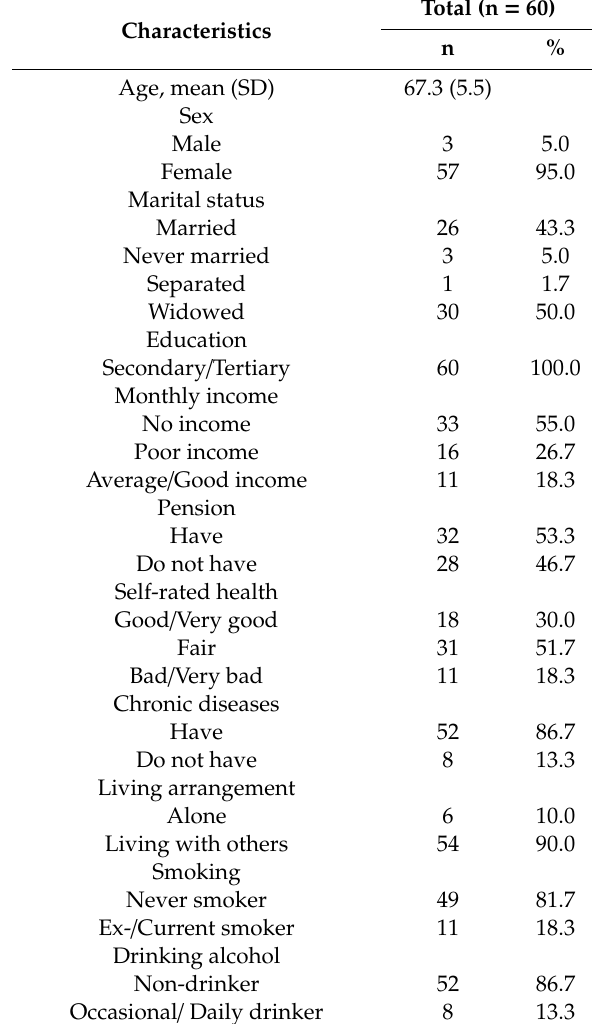
Table 2. Socio-demographic characteristics of peer counselors.